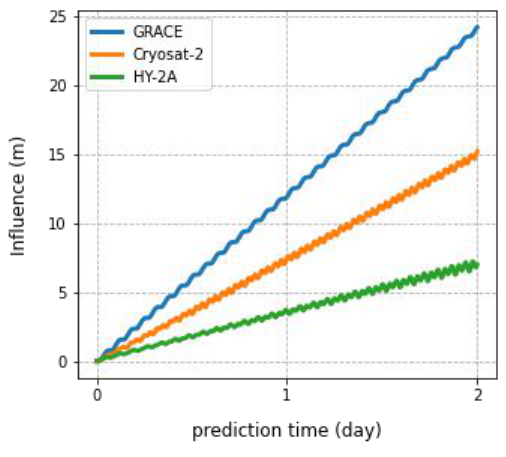
Figure 7. The influence of permanent tide on 3D prediction error of different satellites